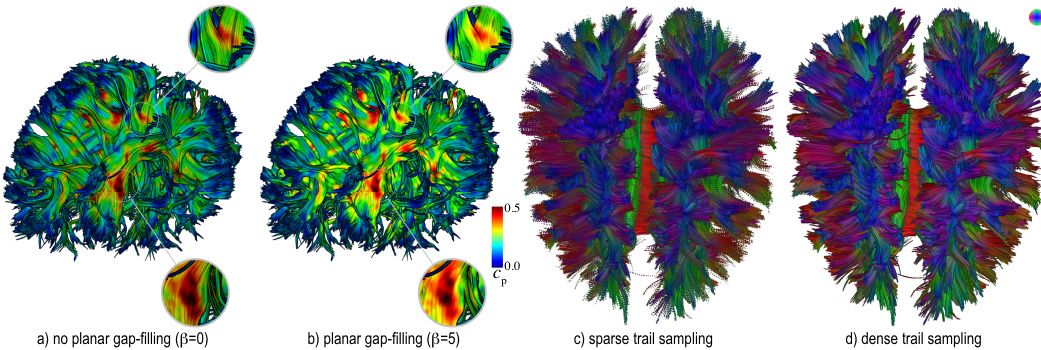
Figure 10. Trail set visualized ( a ) no emphasis of planar regions; ( b ) gap-filling in planar regions; ( c ) sparse, and ( d ) dense trail sampling. Images ( a , b ) are colored by planar anisotropy c p . Images ( c , d ) are colored on trail direction. See Section